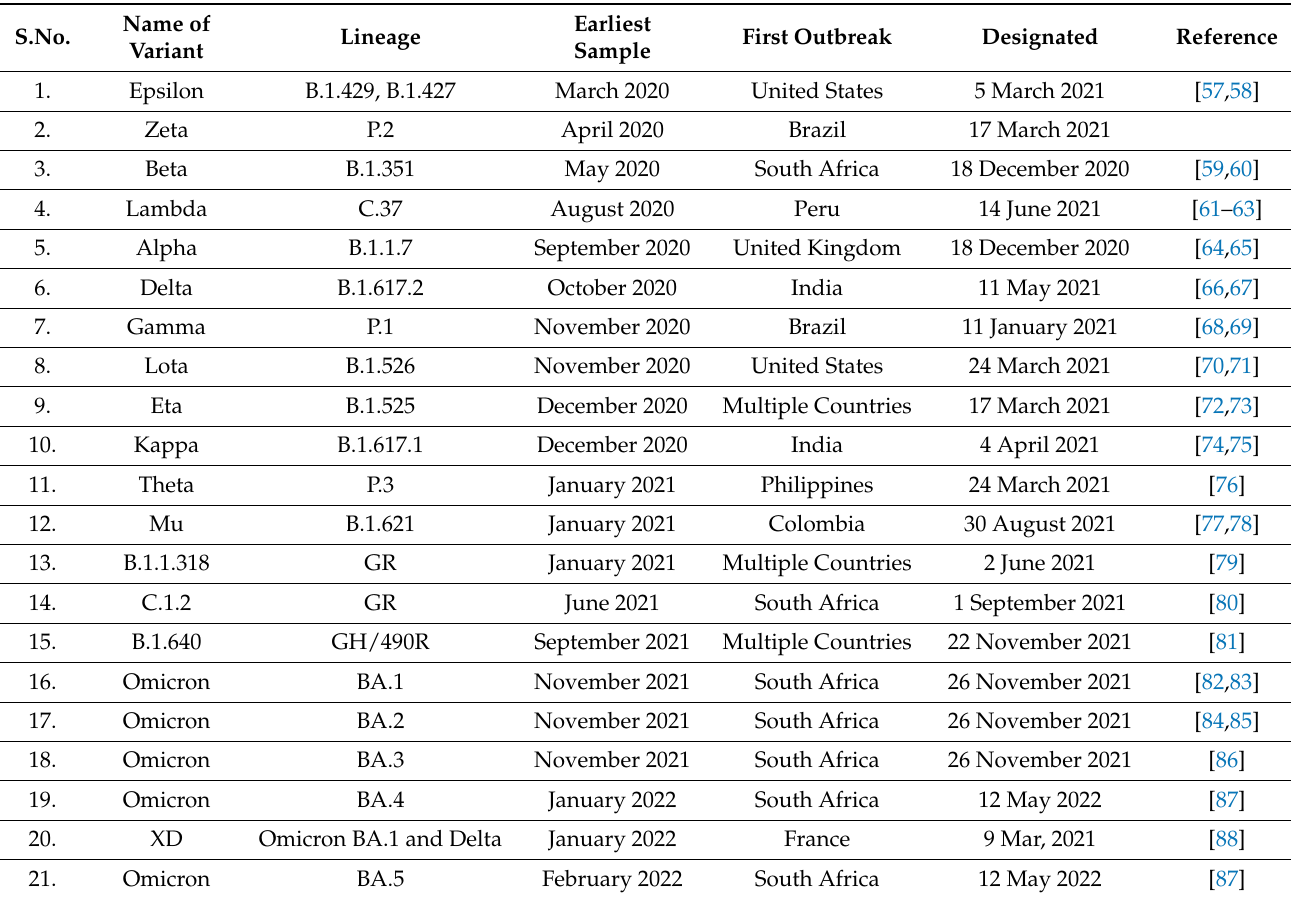
Table 1. List of SARS-CoV-2